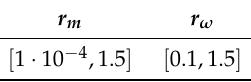
Table 1. Mass ratios r m and frequency ratios r ω used in the numerical